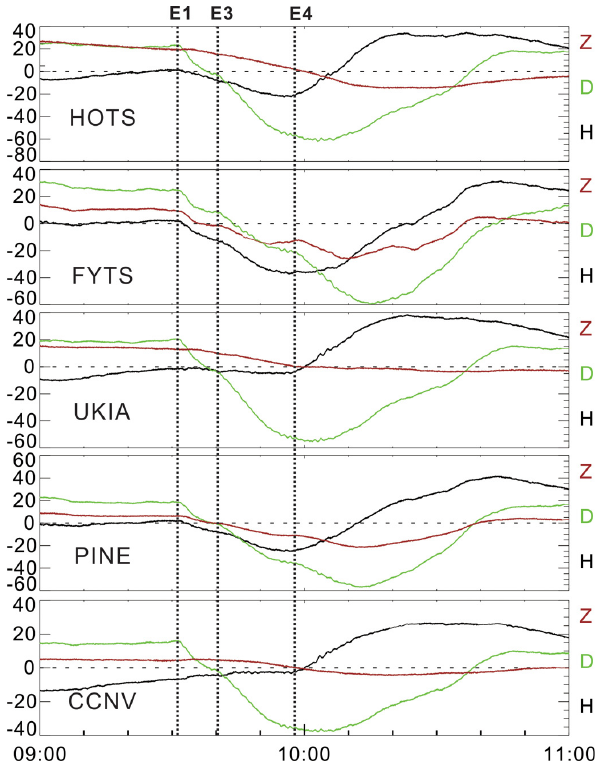
Fig. 3. Mid-latitude observations of the ground magnetic field: de- crease of the D-component occurred three times, at about 09:32UT, 09:41UT, and 09:58UT,